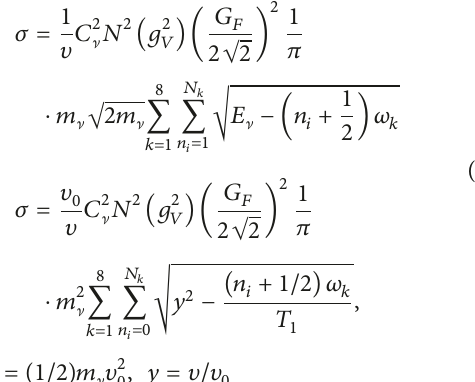
performing the integration using the 𝛿 function we get where IP [𝑥] = integer part of 𝑥 . We thus find 𝑁 𝑘 listed in